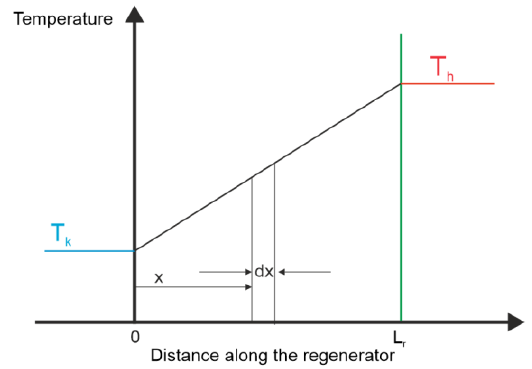
Fig. 8. Temperature distribution in ideal regenerator